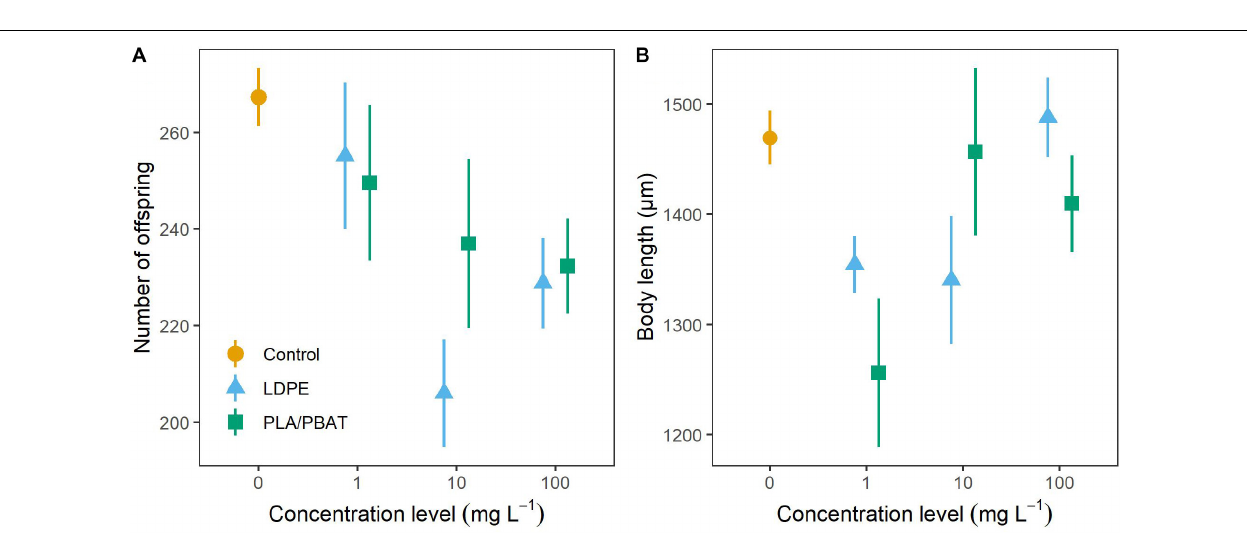
Frontiers in Environmental Science |